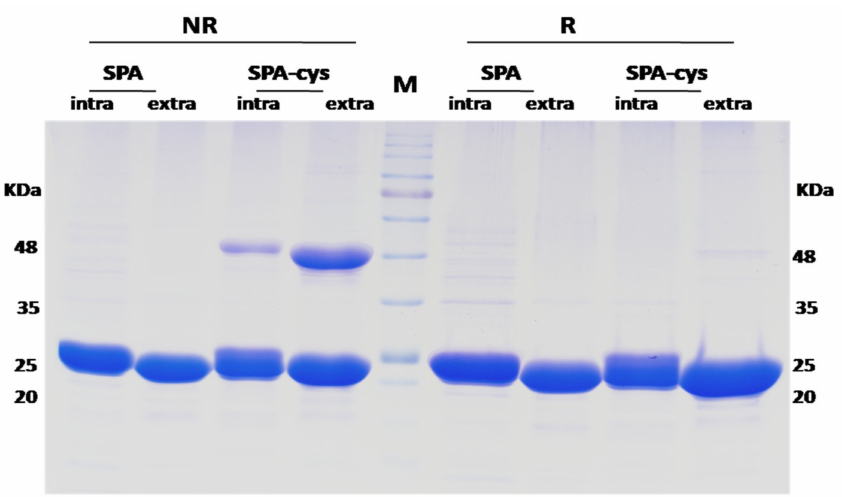
Figure 2. 12% SDS-PAGE analysis of purified protein in reducing and non-reducing conditions. M: Prestained molecular marker, R: purified protein in reduced form, and NR: protein in non-reducing condition, Intra: SPA produced intracellularly, Extra: SPA produced